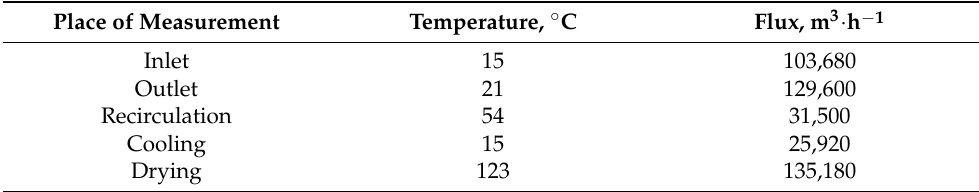
Table 12. Temperatures and streams of drying gas streams of the S428.CS dryer.